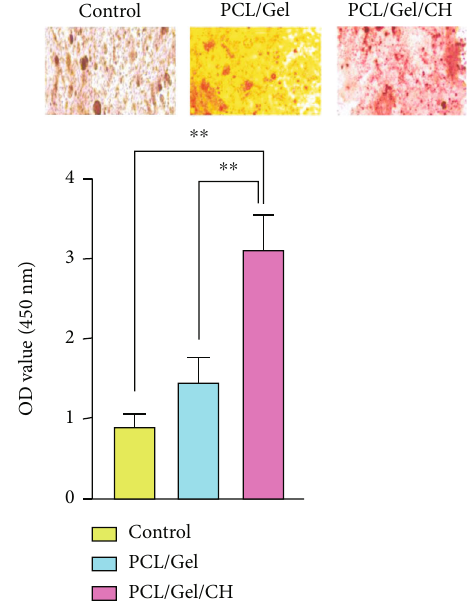
Figure 9: Alizarin Red staining of samples with the magni fi cation of 200 μ m. Cells cultured without sca ff old are considered control. The calcium content of the chrysin-loaded sca ff olds was signi fi cantly higher than in other groups ( ∗∗ p < 0 : 01